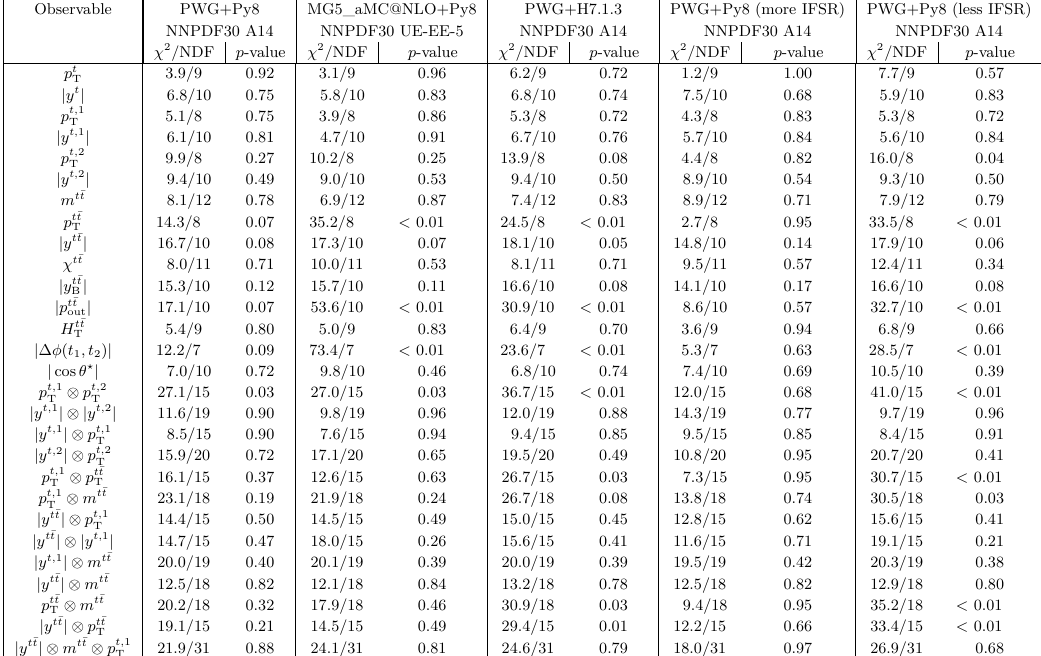
(figure 13) for all MC calculations except for